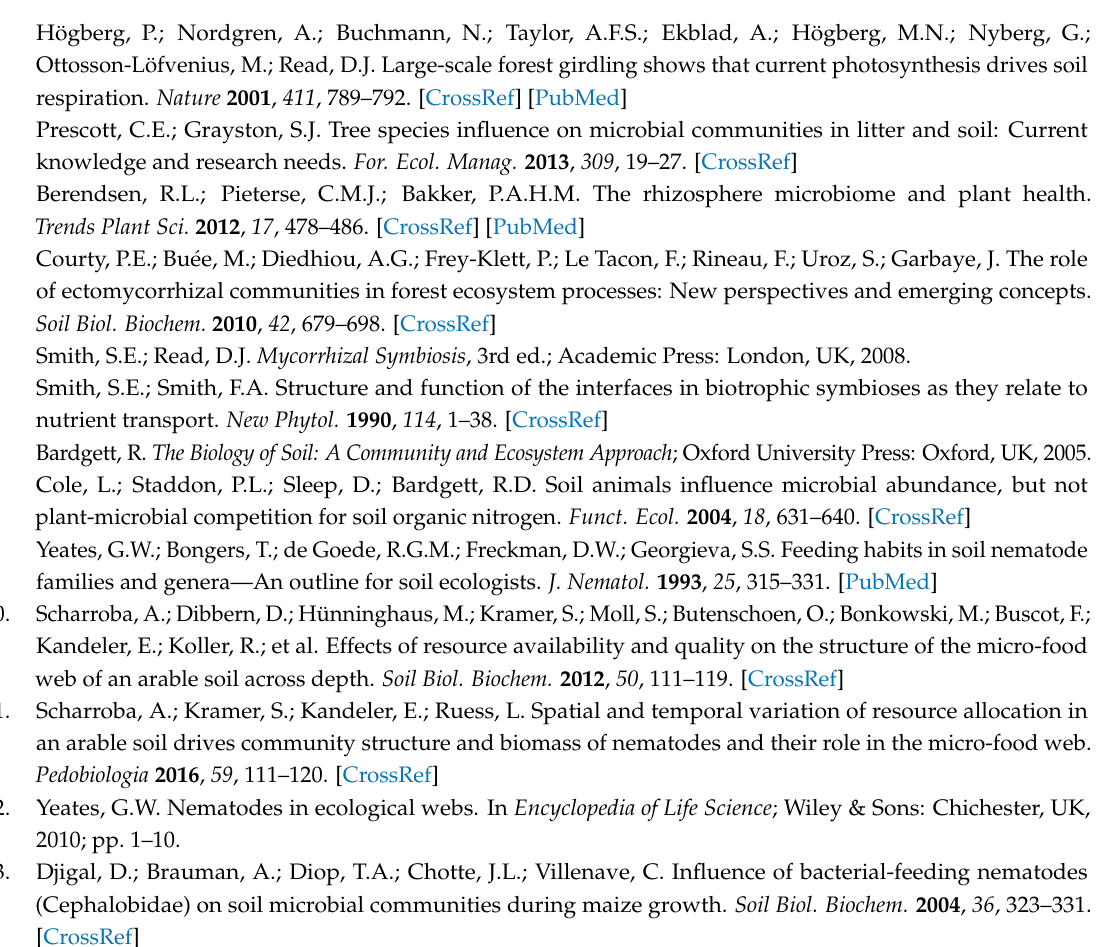
Table S1: Effects of inoculation of nematode trophic groups on the overall population density in the rhizosphere of Quercus robur . Table S2: Effects of inoculation of nematode trophic groups on the relative abundance of the groups and dominant taxa in soil. Table S3: Effects of nematode trophic structure on soil phospholipid fatty acids at 4 weeks after nematode inoculation. Table S4: Effects of nematode trophic structure on soil phospholipid fatty acids at 8 weeks after nematode